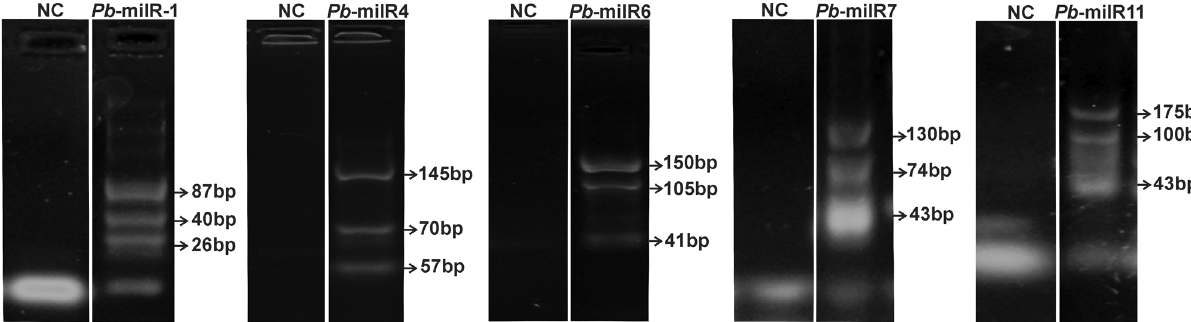
Figure 4 - Qualitative RT-PCR of microRNAs-like predicted by bioinformatics tools. Five potential microRNAs-like were selected on the basis of the highestandlowestMFEvaluesandwereusedforthevalidationexperiments.Eachreactionsamplewasindividuallyfractionatedona3%agarosegeland the fragments sizes were predicted by linear regression. RNA was obtained from P. brasiliensis